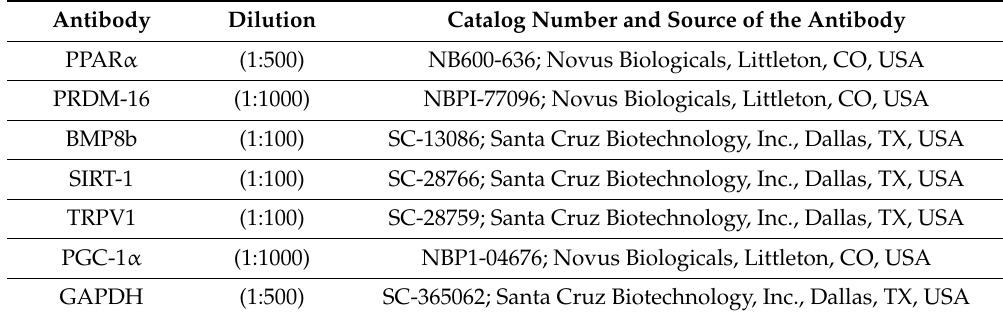
Table 1. Dilutions of antibodies used for immunoblotting experiments.